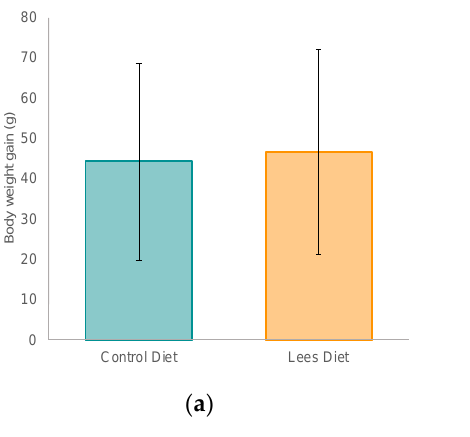
Figure 1. Rats’ body weight gain and daily food and water intake according to the dietary intervention (control or lees diet): ( a ) body weight gain of rats; ( b ) food and water consumption by